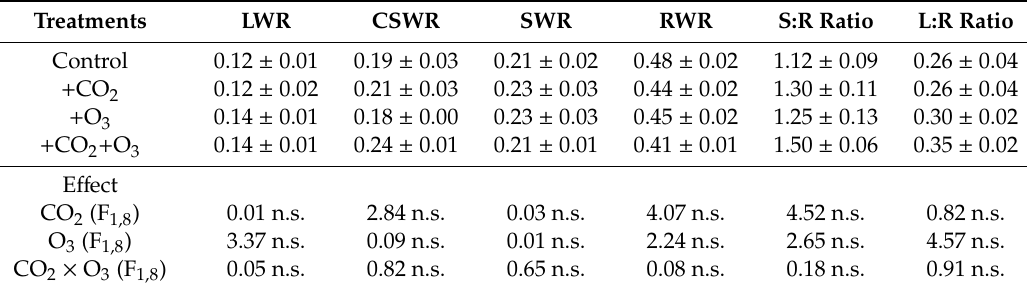
Table 3. Dry matter distribution (leaf weight ratio; LWR, current shoot weight ratio; CSWR, stem and shoot weight ratio; SWR, root weight ratio; RWR, and aboveground biomass to root ratio; S:R ratio, leaf to root ratio; L:R ratio) of the seedling of F. crenata grown under ambient air (control), elevated CO 2 ( + CO 2 ), elevated O 3 ( + O 3 ), and the combination of elevated CO 2 and O 3 ( + CO 2 + O 3 ). Values at upper half lines are means ± SE of three replicates for each treatment. F values of analysis of variance (ANOVA) to test the main e ff ects of CO 2 , O 3 , and their interactions are also shown at lower half lines. There is no significant e ff ect in all parameters, which indicated by n.s.; non-significant. Treatments